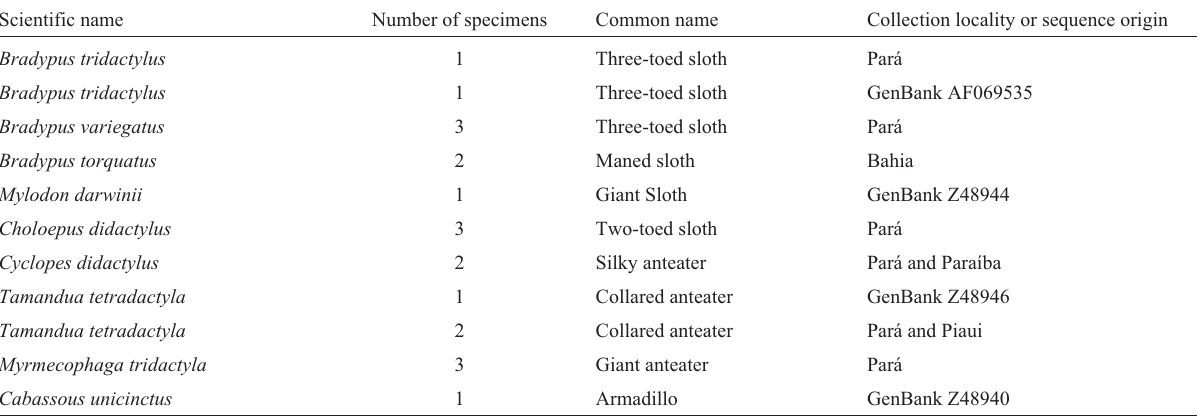
Table 1 - Taxa from which sequences were